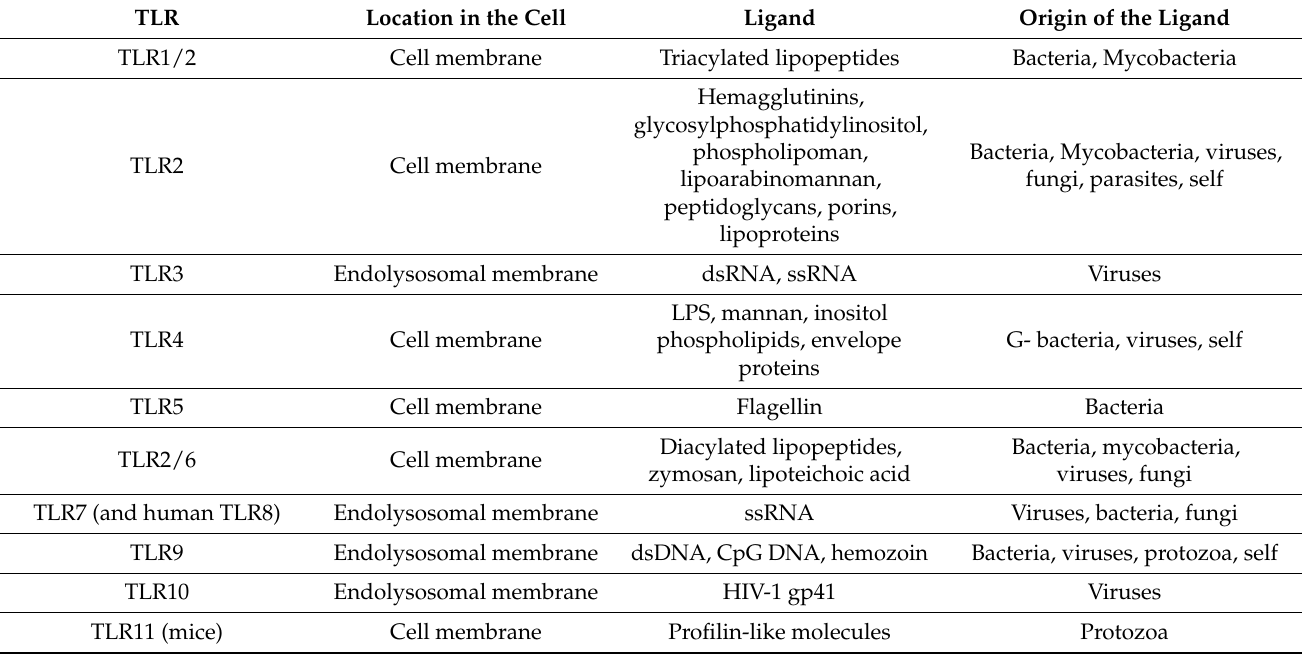
Table 1. Receptor ligands for TLRs; dsRNA-double-stranded RNA, ssRNA-single stranded RNA, LPS-lipopolisacharide, and dsDNA-double-stranded